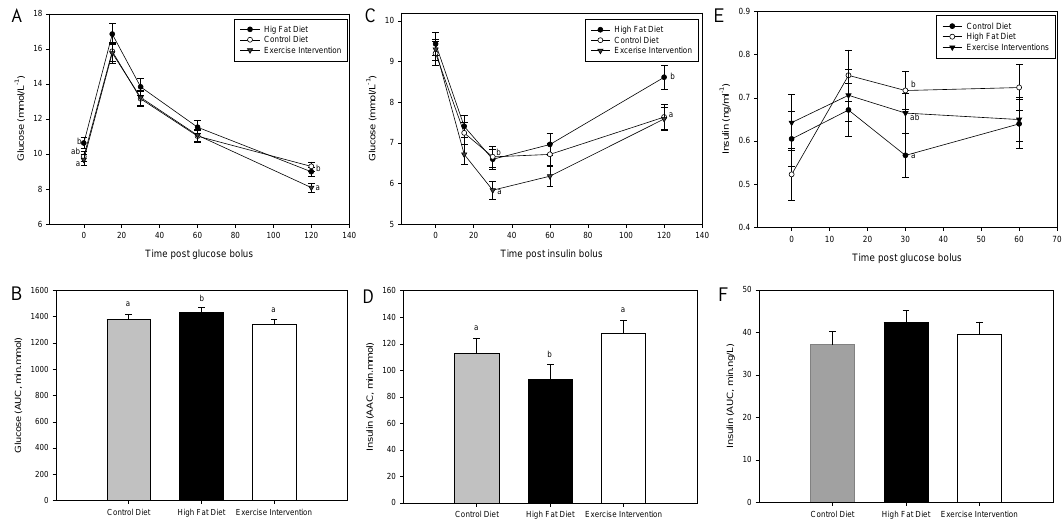
Figure 3. Effect of paternal high fat diet with exercise interventions on male offspring response to a glucose and insulin challenge (16–17 weeks). ( A ) Glucose tolerance as assessed by glucose tolerance test (GTT, 2g/kg); ( B ) Glucose area under the curve (AUC, min · mmol) during GTT; ( C ) Insulin tolerance as assessed by insulin tolerance test (ITT, 0.75 IU); ( D ) Glucose area above the curve (AAC, min · mol) during ITT; ( E ) Insulin secretion during a GTT and ( F ) insulin area under the curve (AUC, min · ng) during GTT. Data is expressed as mean ± standard error mean. n = 10 male offspring from n = 10 litters representative of n = 8 fathers per group. a, b Different letters denote significance at p < 0.05.